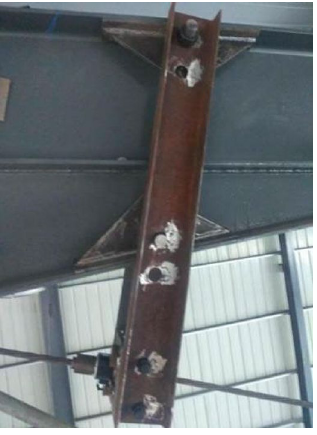
Fig. 5 Realistic picture of the1-shaped anchoring